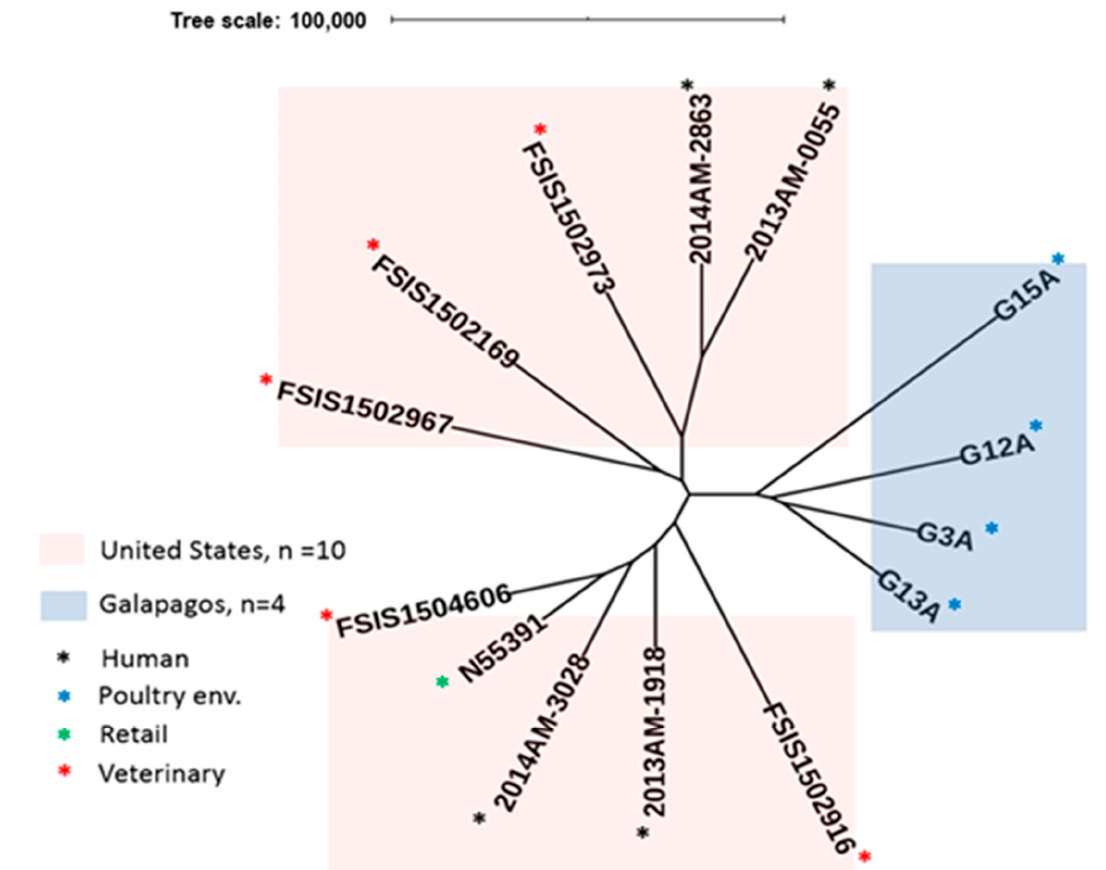
Figure 3. Phylogenetic analysis of Salmonella Infantis isolates from the Galapagos and the United States based on prophage sequence typing. Prophage sequences were extracted from the genome sequences of S. Infantis isolates from the Galapagos (n = 4) and the United States (n = 10;